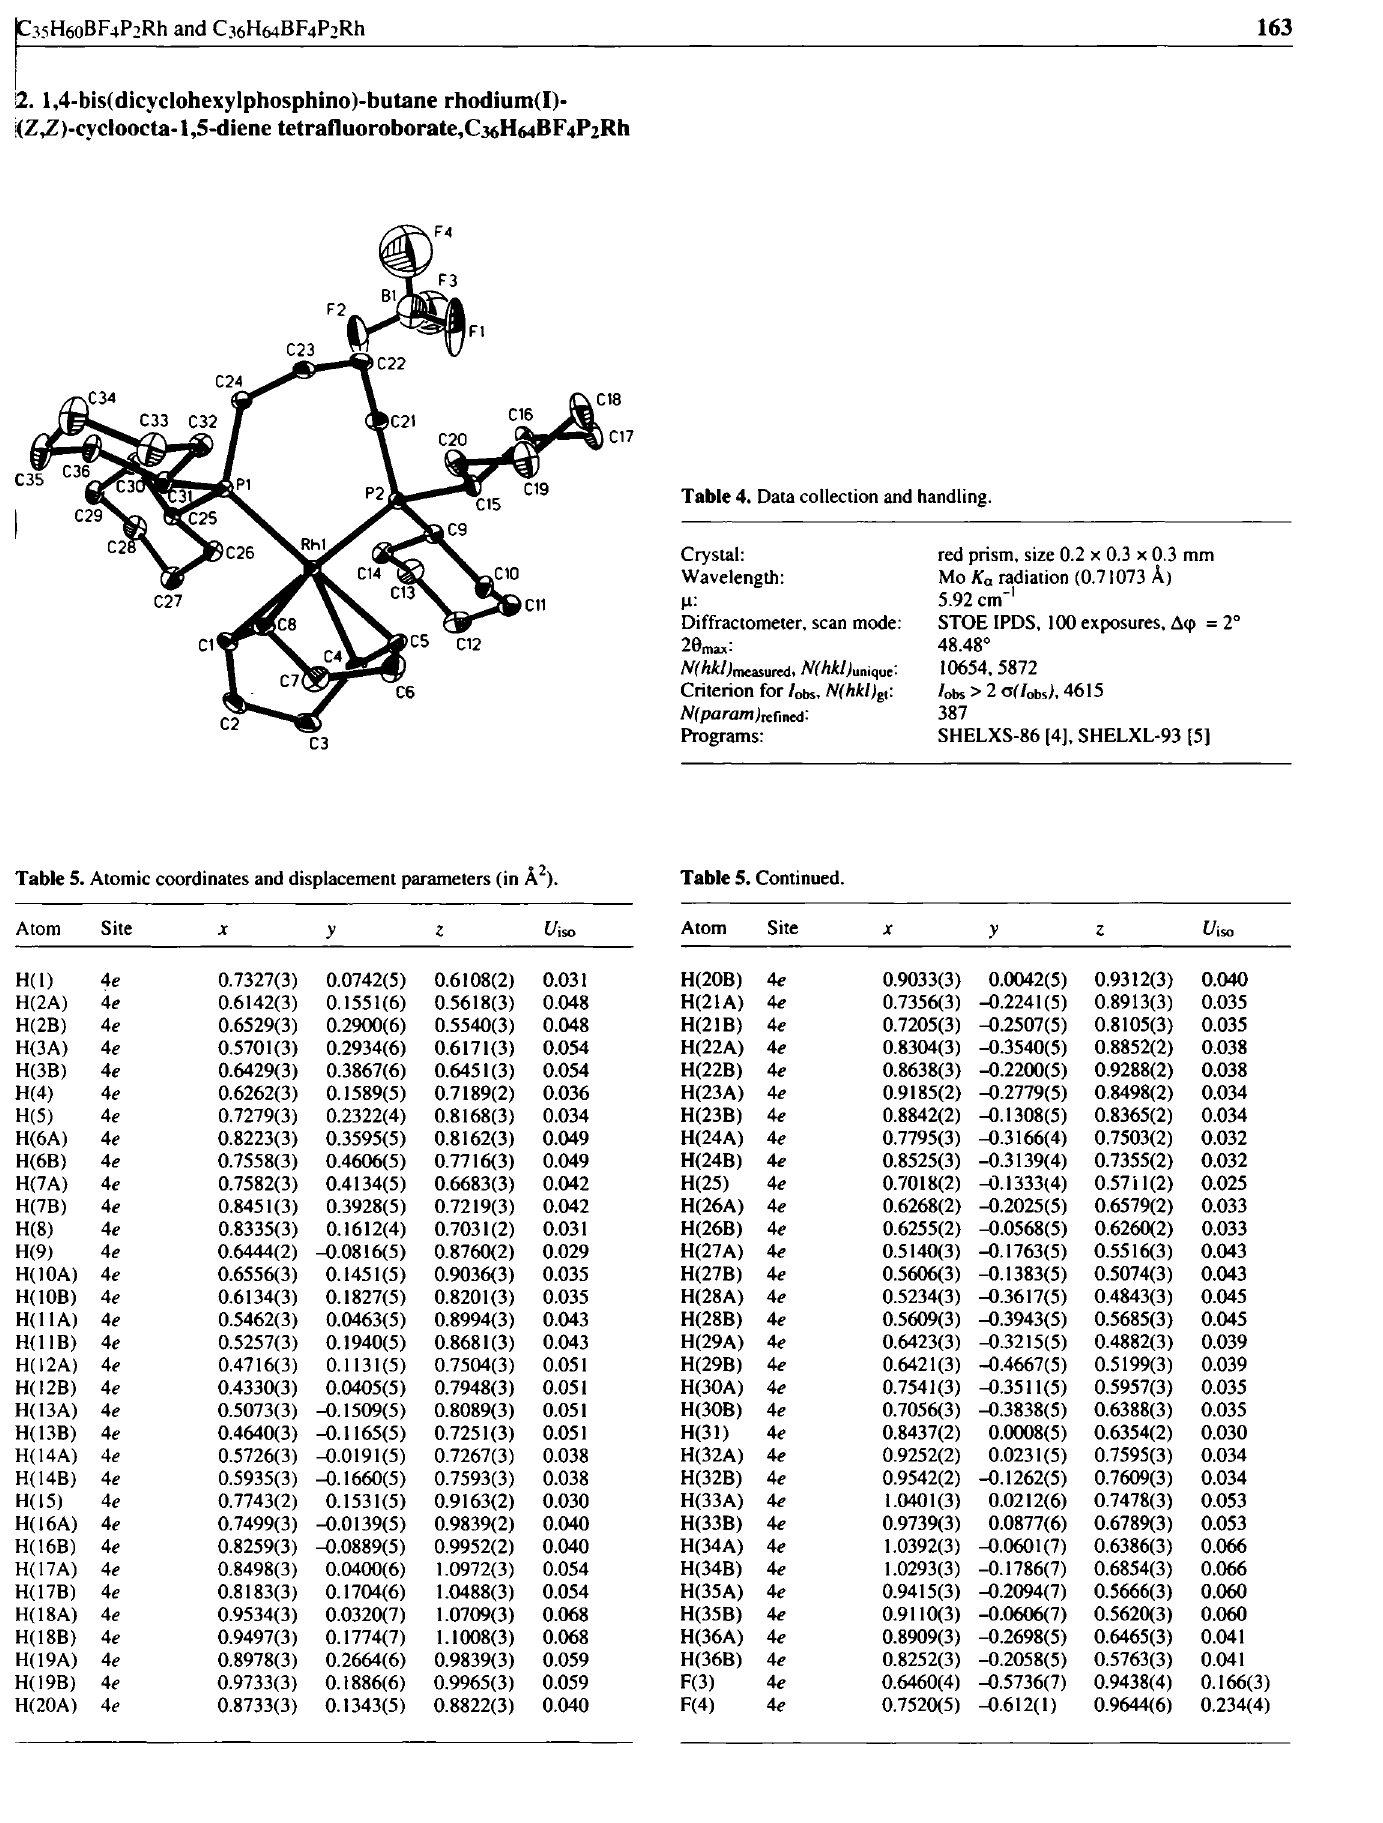
Table 4. Data collection and handling.